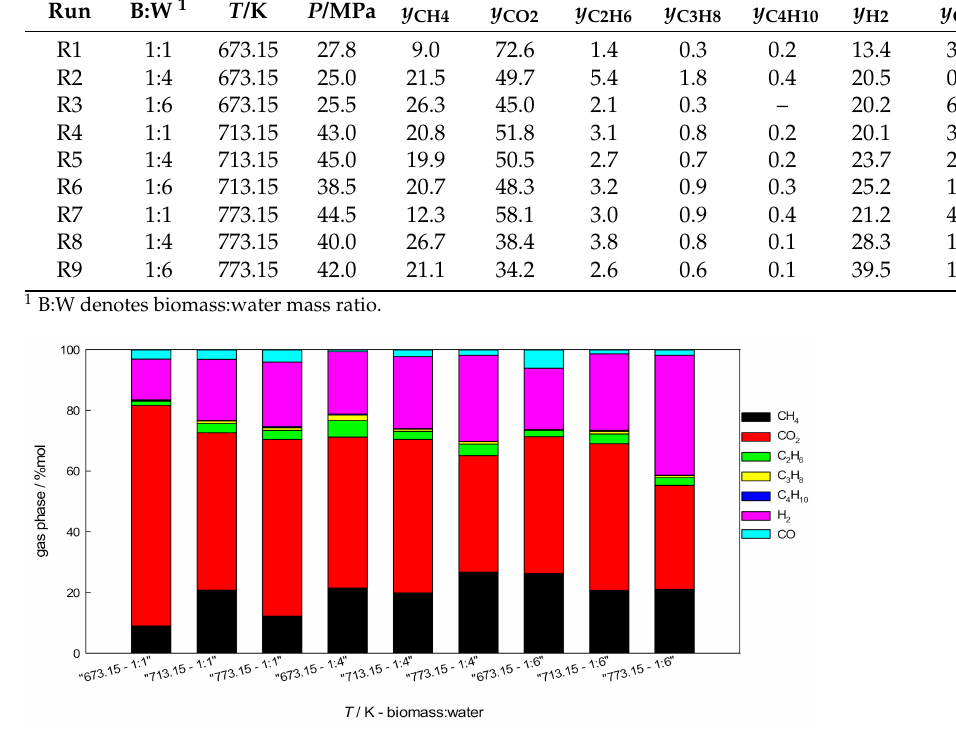
Figure 4. Gas phase products of SCWG from guava fruit waste biomass.